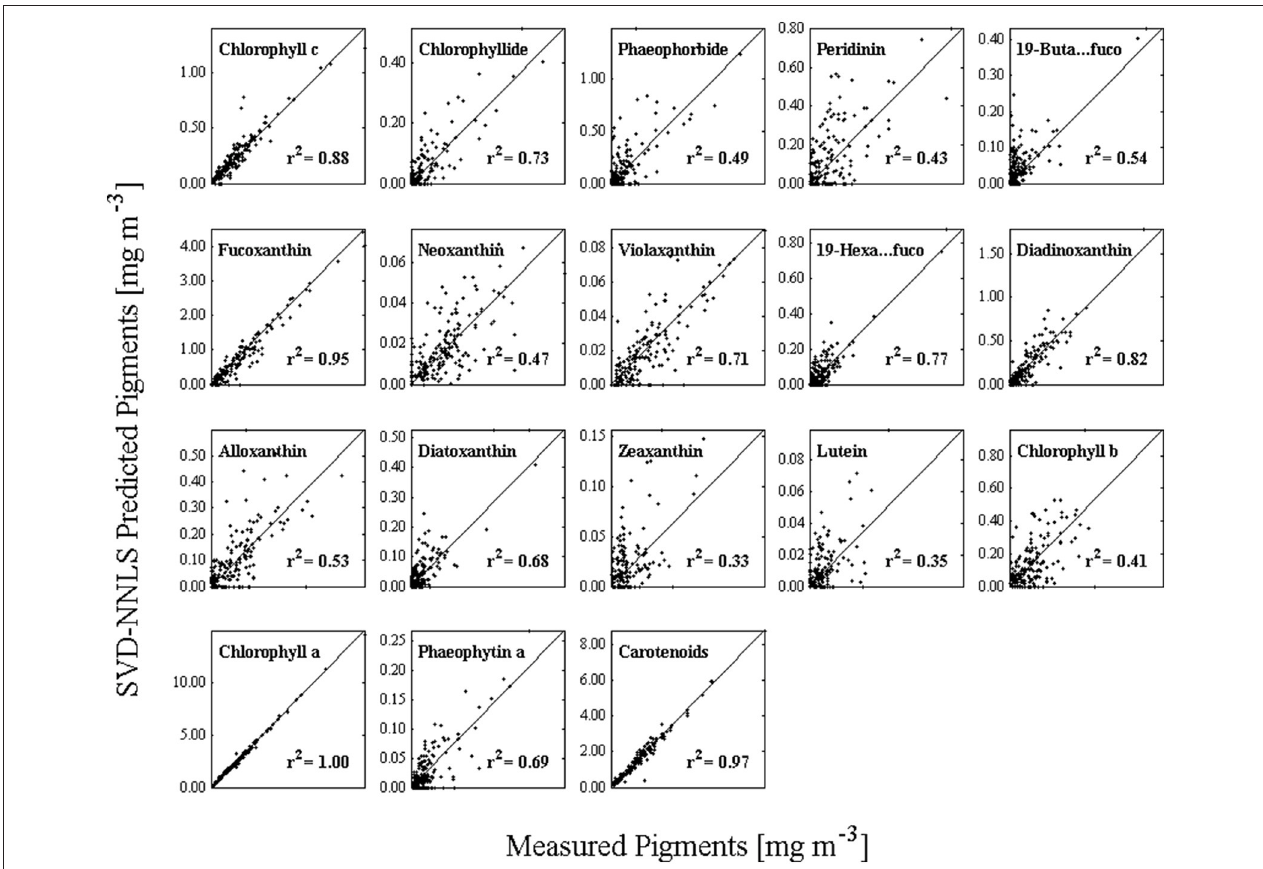
FIGURE 6 | HPLC measured pigments (horizontal axis) versus the predicted pigments (vertical axis) using SVD to obtain the pigment-specific absorption spectra and NNLS to obtain pigment